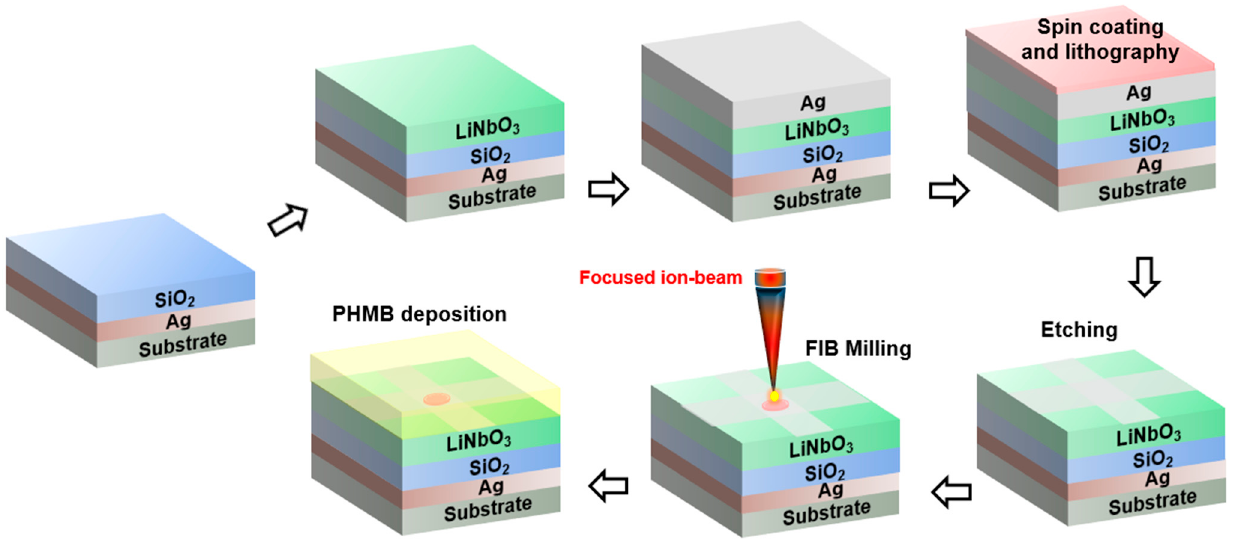
Figure 8. The stepwise proposed fabrication of the CO 2 gas sensor using the host functional layer.